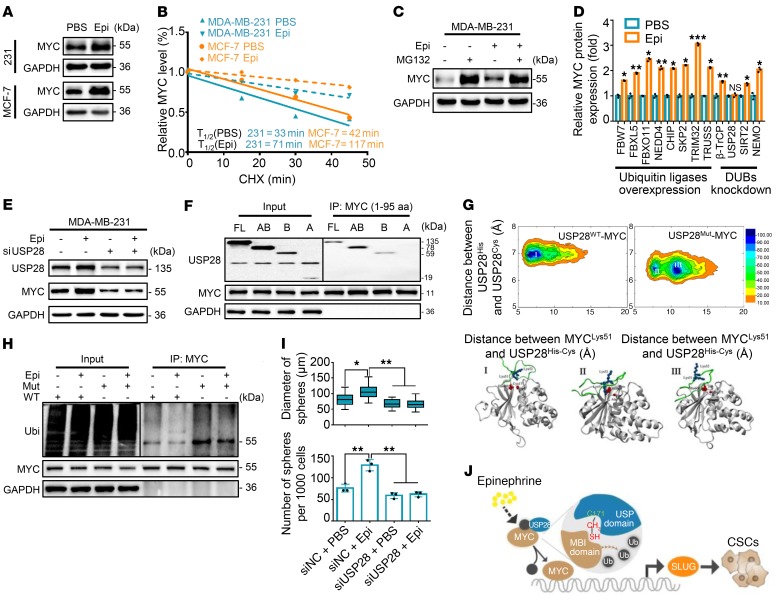
Chronic stress–induced USP28 stabilizes MYC and promotes CSCs.(A) Immunoblots of MYC in MDA-MB-231 and MCF-7 cells treated for 5 days with PBS or Epi. (B) MDA-MB-231 cells were treated with Epi for 5 days followed by treatment with cycloheximide (CHX) for the indicated times. The intensity of MYC expression for each time point was quantified by densitometry and plotted against time. (C) Immunoblots of MDA-MB-231 cells treated with Epi for 5 days and then incubated with or without MG132 for 6 hours. (D) Fold change of immunoblots of MDA-MB-231 cells transfected with indicated plasmids followed by treatment with Epi for 5 days; n = 3 (Student’s t test). (E) Immunoblot analysis of MDA-MB-231 cells transfected with USP28 siRNA-2 followed by treatment with PBS or Epi for 5 days. (F) Immunoprecipitation of USP28 constructs and MYC (amino acids 1–95) in 293T cells. (G) Free-energy surface of the USP28WT-MYC46–74 complex and USP28Mut-MYC46–74 complex (top panel). Gray cartoons, USP28WT/Mut structures; red spheres, side chain of His600 and Cys/Ala171; green cartoons, MYC motifs; blue spheres, Lys51 and Lys52 in MYC motif. (H) Ubiquitin assays of 293T cells transfected with MYC and WT or a C171A mutant (Mut) of USP28 followed by treatment with Epi. (I) Distribution patterns and number (d > 50 μm) of mammospheres from cells in E; n = 3 (1-way ANOVA). (J) Model of Epi-induced cancer stem-like traits through USP28/MYC/SLUG signaling. Data are representative of at least 3 independent experiments. Data represent mean ± SEM; *P < 0.05, **P < 0.01, ***P < 0.001.